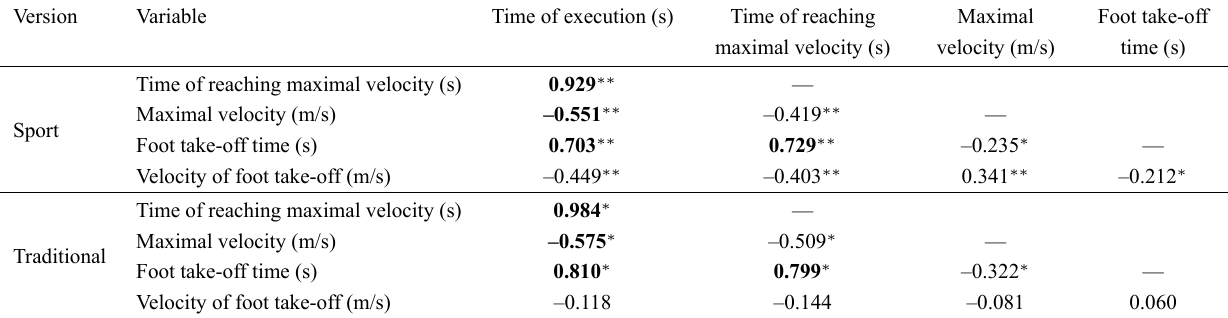
Table 4. Correlation table between chosen kinematic variables for roundhouse kick.